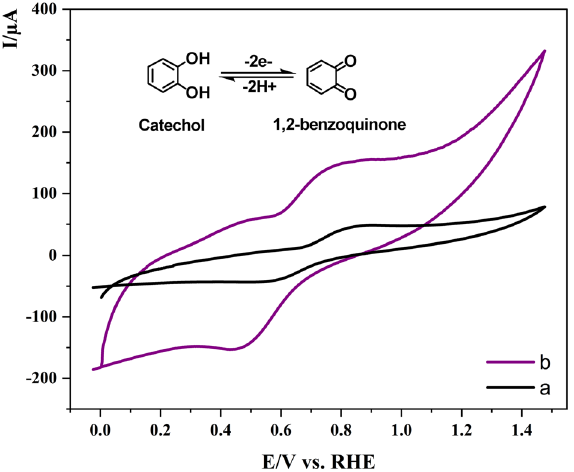
Figure 3. Cyclic voltammograms of 1 mM catechol at the surface of (a) GCE and (b) Co-MOF/GCE in aqueous phosphate buffer solution (pH = 3), scan rate: 100